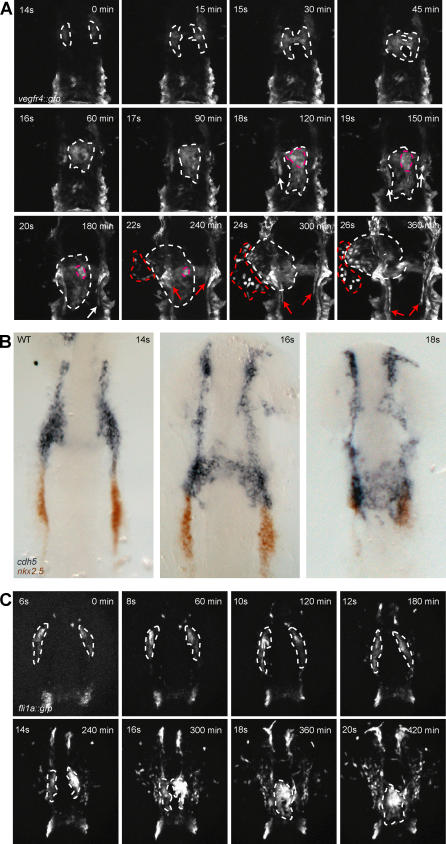
Migration of Endocardial Precursors in wt Embryos(A) Embryos transgenic for vegfr4:gfp were subjected to time-lapse confocal microscopy, revealing rapid endocardial migration prior to heart tube formation. A movie demonstrating this process can be viewed in the Video S1. Twelve individual frames from this movie at indicated stages and time-points are shown seen in (A), with white dashed lines indicating the position of (pre-) endocardial cells. Frames 1–5 show the fusion of the bilateral endocardial precursors between the 14- and 16-somite stages. Frames 5–8 indicate the posterior migration of endocardial cells to cover the lateral and posterior regions of the cardiac disc; note the posterior migration of the paired lateral dorsal aortas between the 18- and 22-somite stages (white arrows). The apex of the endocardial disc (pink dashed line) appears to be constricted below the aortic arches between the 18- and 22-somite stages (frames 7–10). A leftward movement of the endocardium is visible between the 20- and 26-somite stages (frames 9–12), and is coinciding with the appearance of single vegfr4:gfp-positive cells lateral to the remaining endocardium (red dashed line). Also note the migration of the venous posterior hindbrain channels (red arrows) between the 22- and 26-somite stage (frames 10–12).(B) Relative locations of endocardial and myocardial precursors during fusion of endocardial precursor populations, revealed by two-color in situ hybridization showing cdh5 (blue, endocardium) and nkx2.5 (red, myocardium) expression. The bilateral populations of endocardial precursors (arrows) are located anterior to the myocardial precursors until the 14-somite stage, then migrate medially and posteriorly to assume a position in between the myocardial precursors at the 18-somite stage.(C) Embryos transgenic for fli1a:gfp were subjected to time-lapse confocal microscopy, revealing slow medial movement of gfp-positive cells between the six- and 12-somite stage (frames 1–4) and rapid migration starting at the 14-somite stage. A movie demonstrating this process can be viewed in the Video S2.